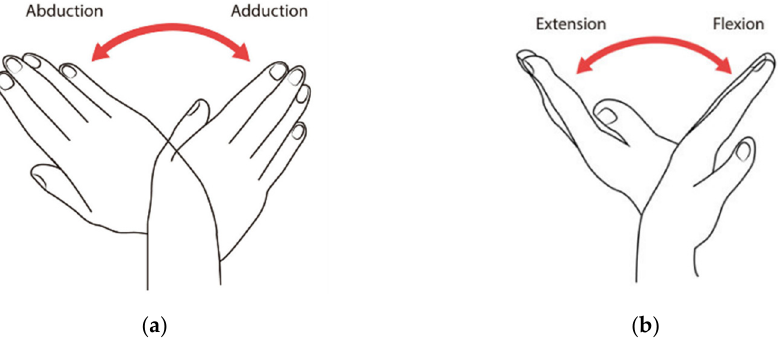
Figure 1. ( a ) Abduction/adduction wrist movements; ( b ) flexion/extension wrist movements.